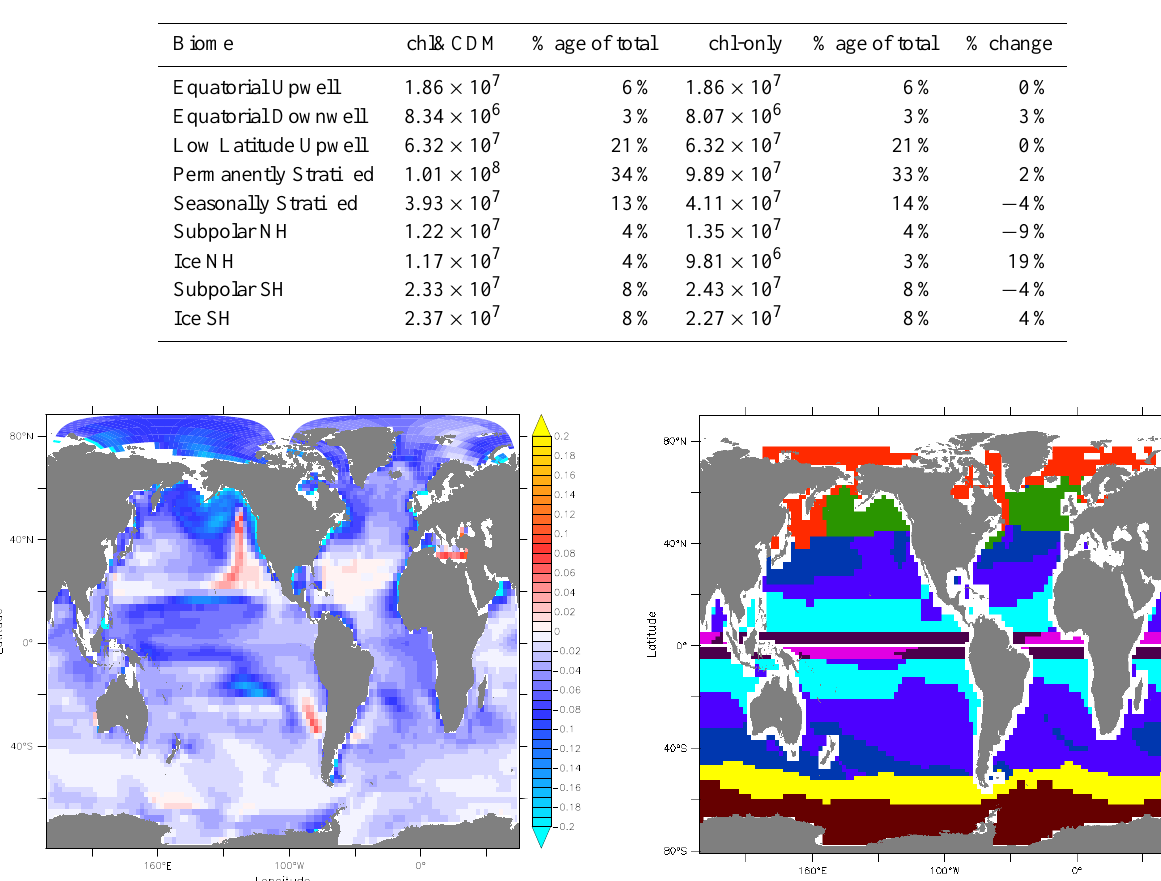
Table 1. Surface area by biome, in km 2 with percentage change in area between the two model runs (chl&CDM minus chl-only).